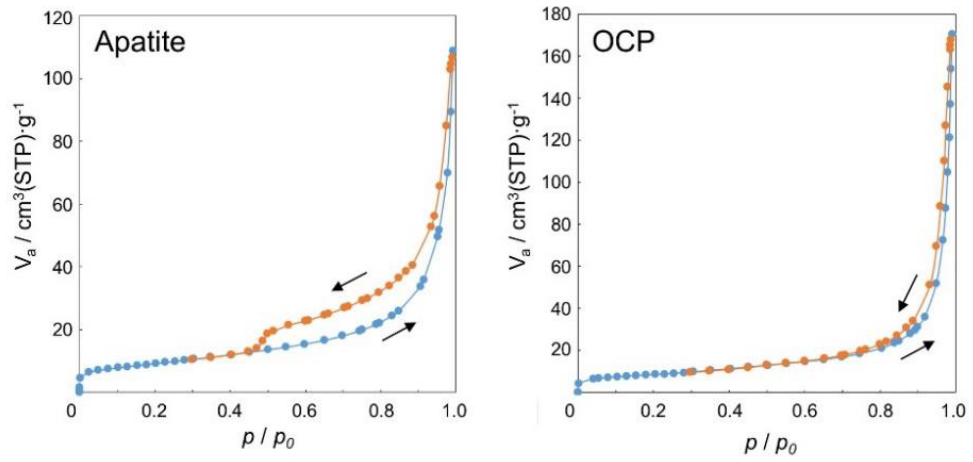
Figure 4. Adsorption isotherm of the apatite and OCP microspheres.